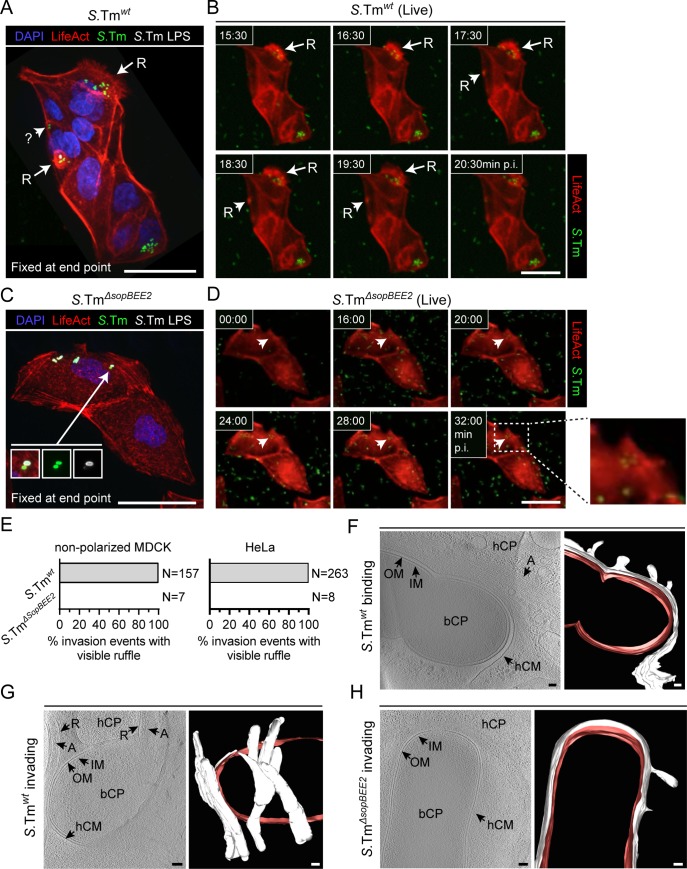
SipA drives S.Tm epithelial cell invasion without triggering higher order actin meshworks.(A-E) By contrast to S.Tmwt, S.TmΔsopBEE2 invades non-polarized epithelial cells in the absence of visible ruffles. (A-B) Non-polarized LifeAct-expressing MDCK cells (red) were infected with S.Tmwt/pmCherry (green) at MOI 50. (A) Representative micrograph of cells fixed at the end point (24min p.i.). Successful invasion was scored by α-S.Tm LPS-staining prior to permeabilization. R–ruffle ;? —ambiguous entry event revealed as a ruffle in the live series. (B) Live imaging series preceding A. Arrow/Arrow heads labelled R indicate extensive and transient ruffles, respectively. (C-D) MDCK cells as in A-B were infected with S.TmΔsopBEE2/pmCherry (green) at MOI 500. (C) Representative micrograph of cells fixed and stained at the end point (40min p.i.). (D) Live imaging series preceding C. Arrow head indicates a ruffle-less entry focus. Scale bars in A-D: 20μm. (E) Live imaging-based quantification of the presence/absence of ruffles at S.Tmwt and S.TmΔsopBEE2 entry sites in non-polarized MDCK (left; Ntot = 164 invasion events) and HeLa (right graph; Ntot = 271 invasion events analyzed). (F-H) Ultrastructural underpinnings of SipA-driven epithelial cell invasion. Cryo-electron tomograms of HeLa cells infected with S.Tmwt (F-G; Ntot tomograms = 20, frozen at 14min p.i.), or S.TmΔsopBEE2 (H; Ntot tomograms = 13; frozen at 40min p.i.). Shown in each case is a 15-17nm slice of a tomogram and the respective segmentation. R—ruffle; OM—outer membrane; IM—inner membrane; bCP—bacterial cytoplasm; hCP—host cell cytoplasm; hCM—host cell membrane; A—actin filaments; white pseudo-coloring—host cell membrane; red pseudo-coloring—bacterial membrane. Scale bars in F-H: 100 nm.